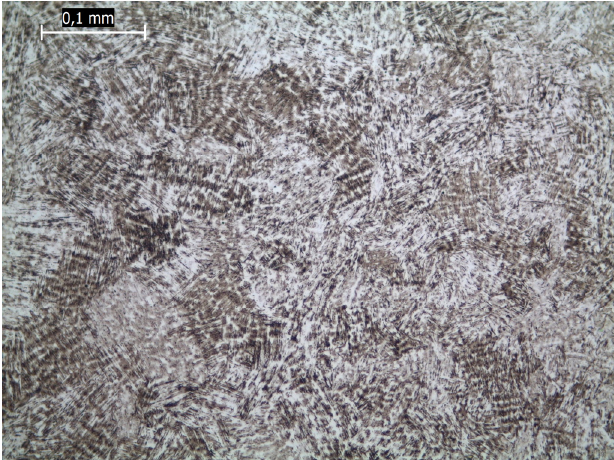
Figure 2: Optical micrograph showing the alloys’ microstructure.